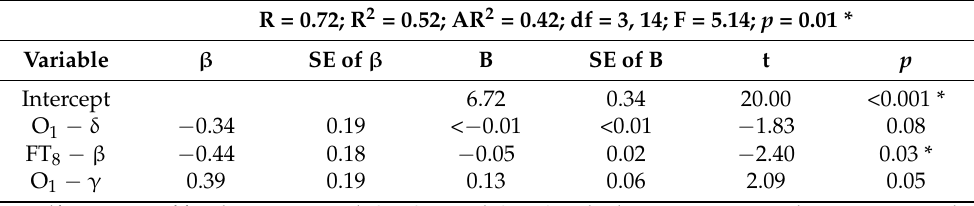
Table 2. Regression analysis for log-transformed low frequency heart rate variability and electroen- cephalography variables in train drivers.